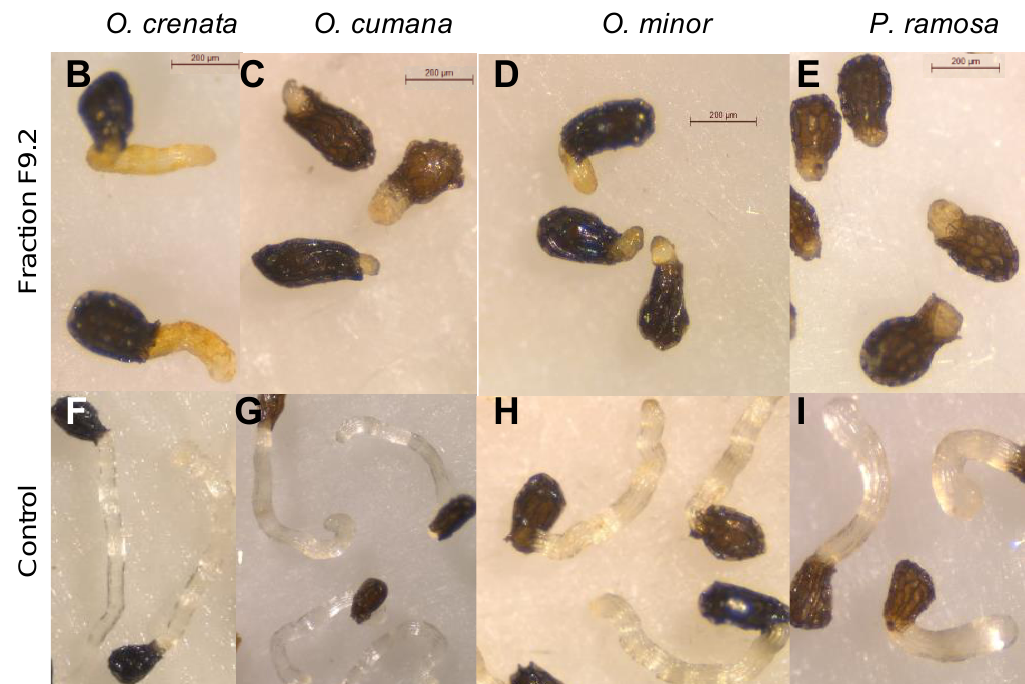
Figure 2. ( A ) Inhibition of broomrape radicle growth induced by fractions (F9.1, F9.2 and F9.3) obtained from the phytotoxic ninth fraction of the extract of roots of Convolvulus arvensis expressed as a percentage with respect to the control GR24. ( B – I ) Photographs illustrating the effects of fraction F9.2 in radicles of ( B ) Orobanche crenata , ( C ) Orobanche cumana , ( D ) Orobanche minor and ( E ) Phelipanche ramosa in comparison with the effect of the control treatment in ( F ) Orobanche crenata , ( G ) Orobanche cumana , ( H ) Orobanche minor and ( I ) Phelipanche ramosa . Analysis of variance was applied to transform replicate data. For each broomrape species, bars with different letters are significantly different according to the Tukey test ( p = 0.05). Error bars represent standard error.